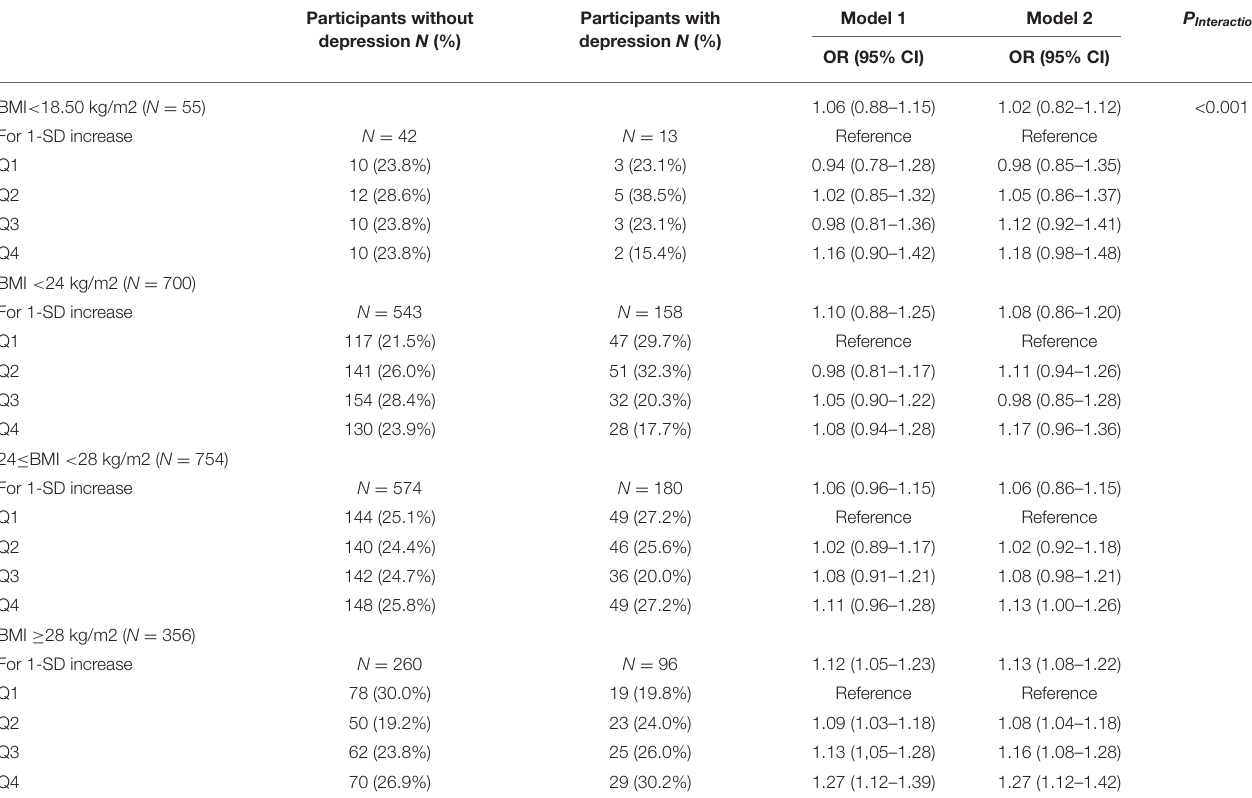
TABLE 3 | Risk of depression by quartile of dietary inflammatory index stratified according to BMI ( N = 1,865).